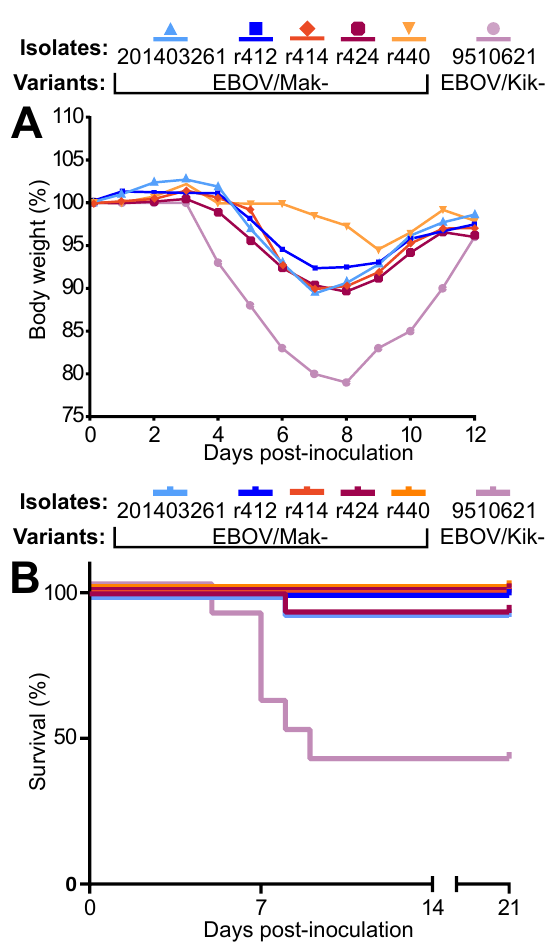
Figure 5. Recombinant EBOV/Mak-G3864.1 caused weight loss in INFAR − / − mice. Groups of 10 INFAR − / − laboratory mice were inoculated intraperitoneally with ≈ 1000 PFU of rEBOV/Mak- G3864.1 mutant isolates r412, r414, r424, or r440 or natural isolates EBOV/Mak-201403261 (TD) or EBOV/Kik-9510621 [10]. Weight ( A ) and survival ( B ) were monitored daily for up to 21 d. INFAR − / − = interferon-alpha/beta receptor